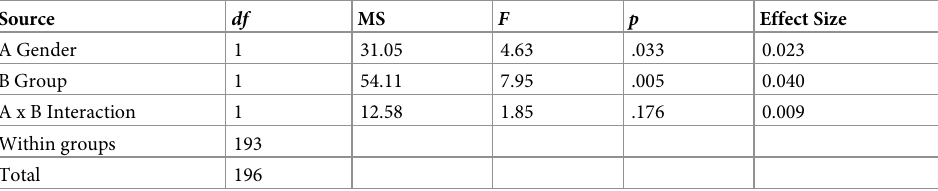
Table 8. ANOVA summary table for anxiety.